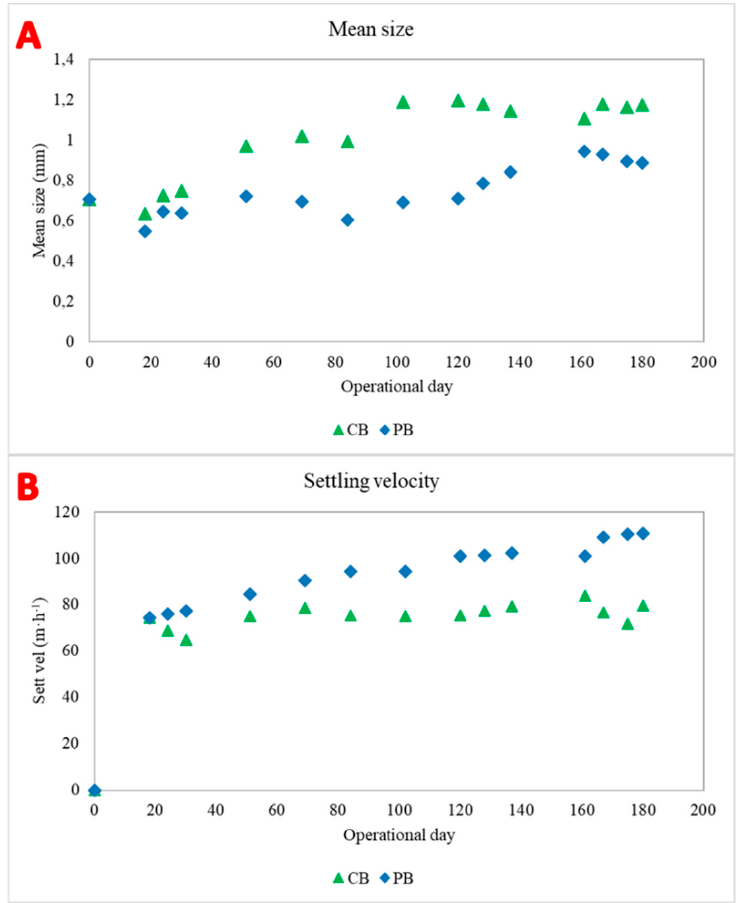
Figure 1. Mean size ( A ) and settling velocity ( B ) of granular biomass grown in CB (green triangle) and PB (blue diamond).